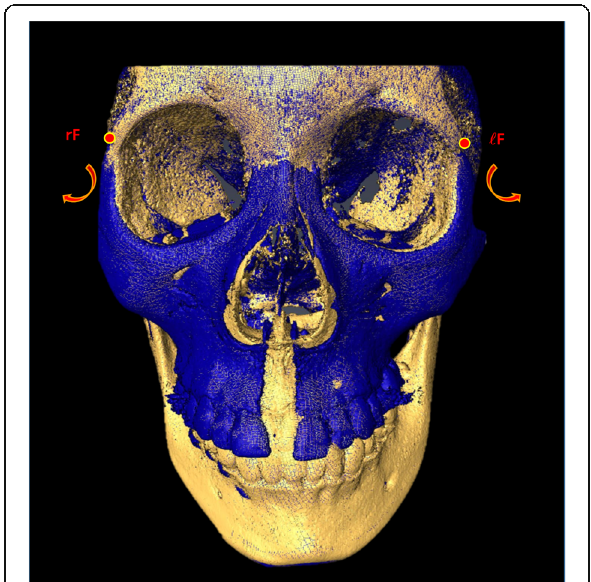
Fig. 9 Superimposed 3D model of an MSE patient displaying the rotational pattern of the zygomaticomaxillary complex. Yellow, pre- expansion; blue, post-expansion; rF, right fulcrum; ℓ F, left fulcrum. Structures medial and above the fulcrum are stable. Red arrows show the outward and downward direction of the expansion on the coronal